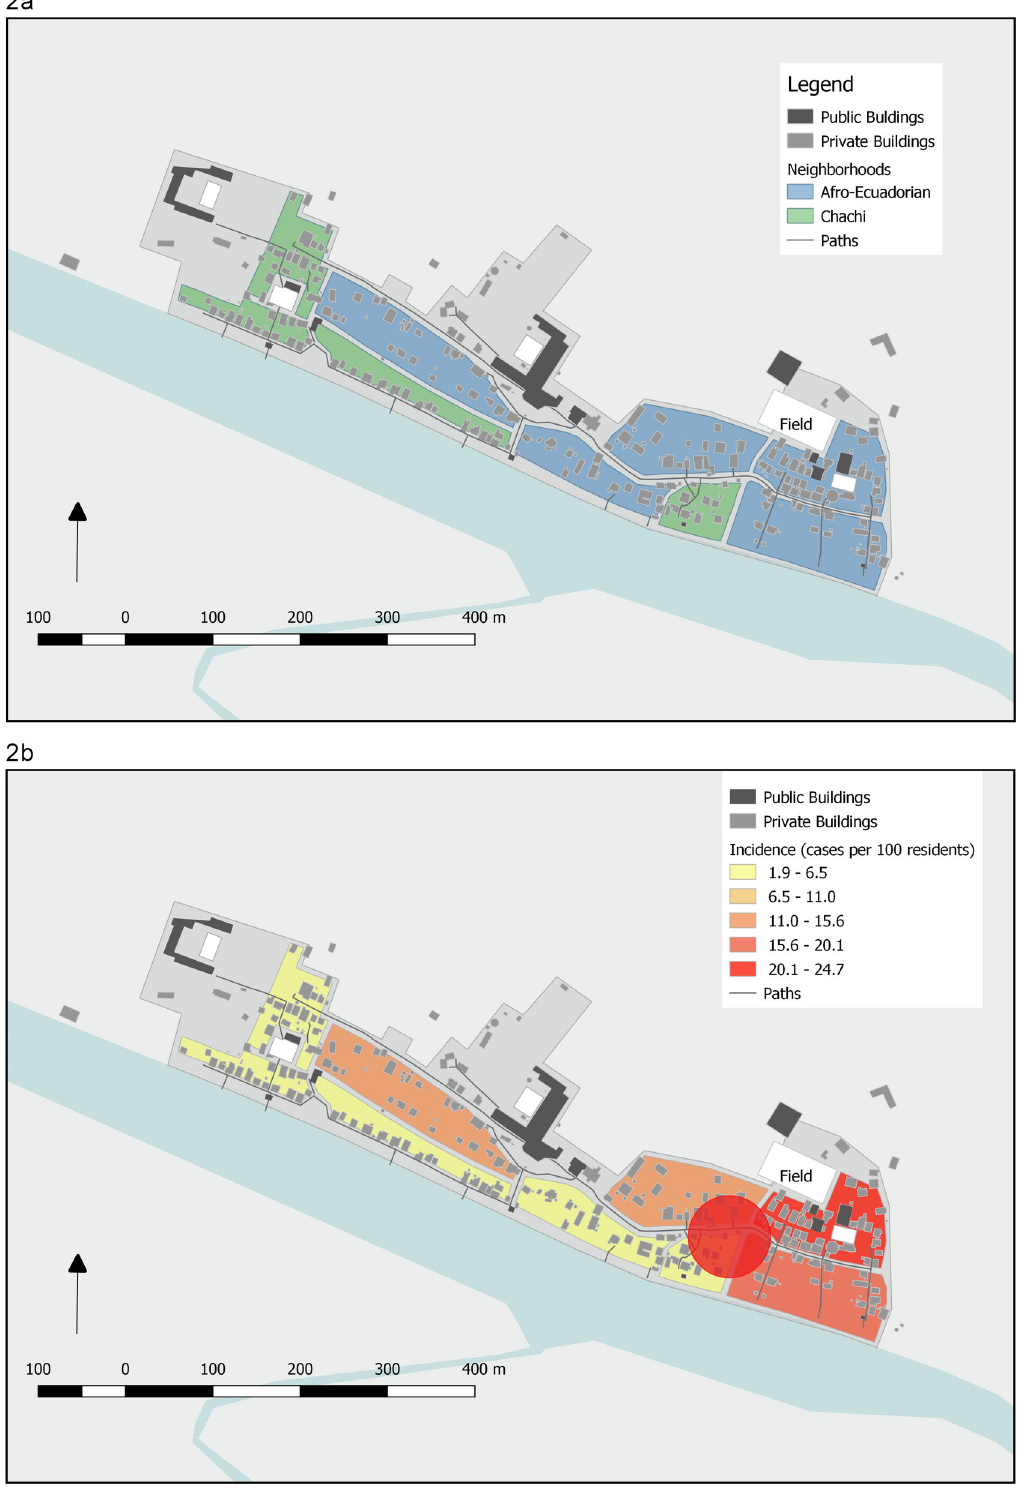
Fig 2. Community Map. The study community. 2a. Neighborhoods are coded by the reported ethnicity of the occupants. ‘Field’ represents the football field that represented a spatial risk factor in the outbreak. 2b. The red circle in indicates the part of the community where Ae. Aegypti were identified. For privacy reasons, we do not identify specific households where dengue cases occurred, or where Ae. Aegypti were identified. These maps were constructed de novo by the study team. https://doi.org/10.1371/journal.pntd.0009679.g002 PLOS NeglectedTropical Diseases | https://doi.org/10.1371/journal.pntd.0009679 September 27,